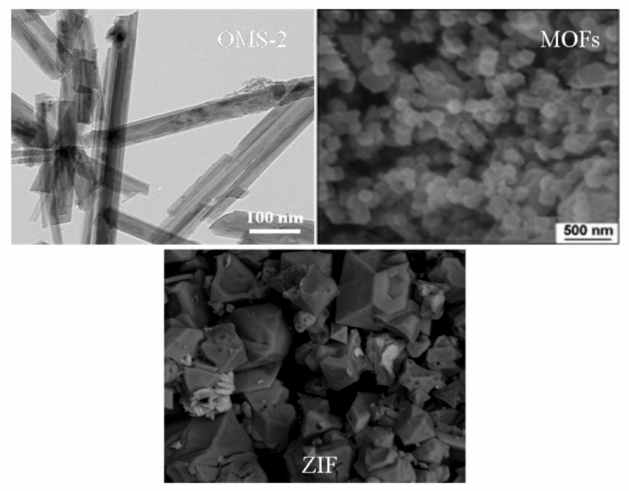
Figure 2. Microscopic structure of OMS-2, MOFs, and ZIF